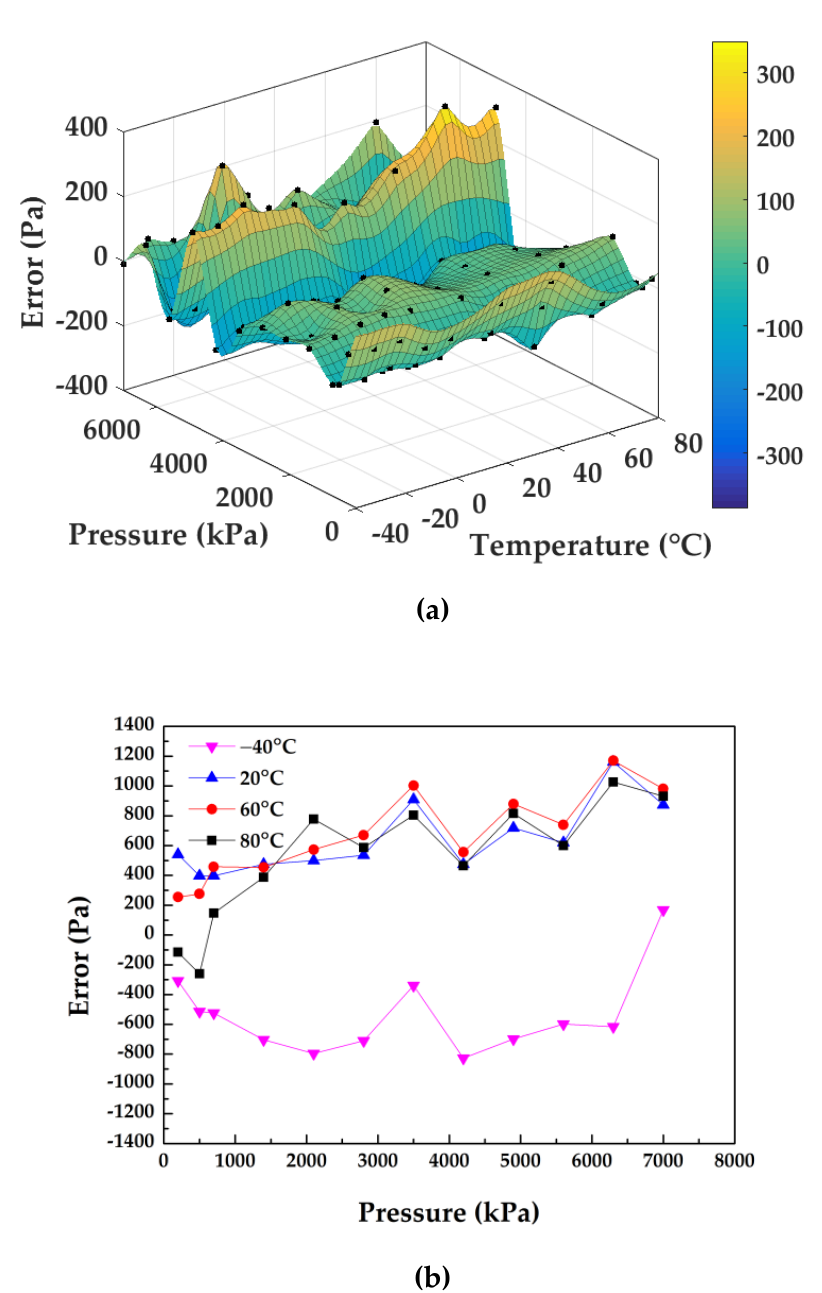
Figure 10. ( a ) The surface fitting of the sensor from the calibration process; ( b ) the measurement errors curve at − 40 °C, 20 °C, 60 °C and 80 °C in three cycles.